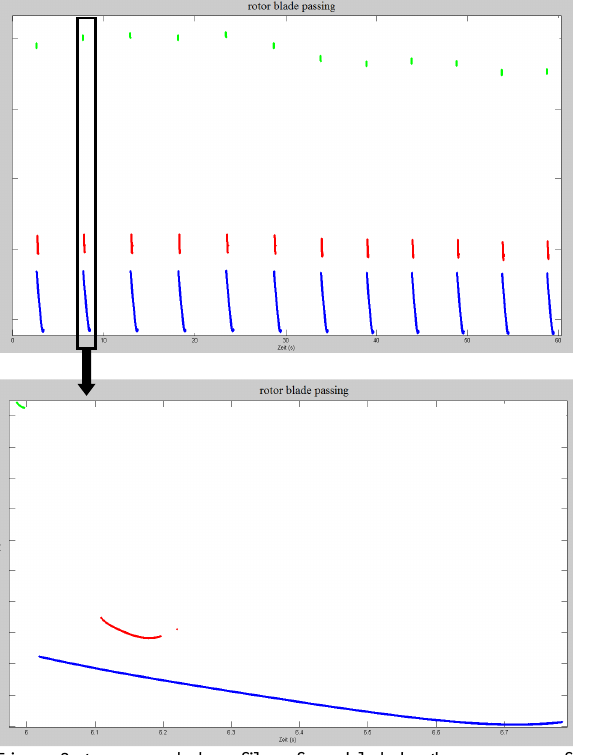
Figure 8: top: recorded profiles of one blade by three scanners for 60 seconds, bottom: recorded profiles of one blade in one cycle; blue: close to the hub, red: center; green: outer tip